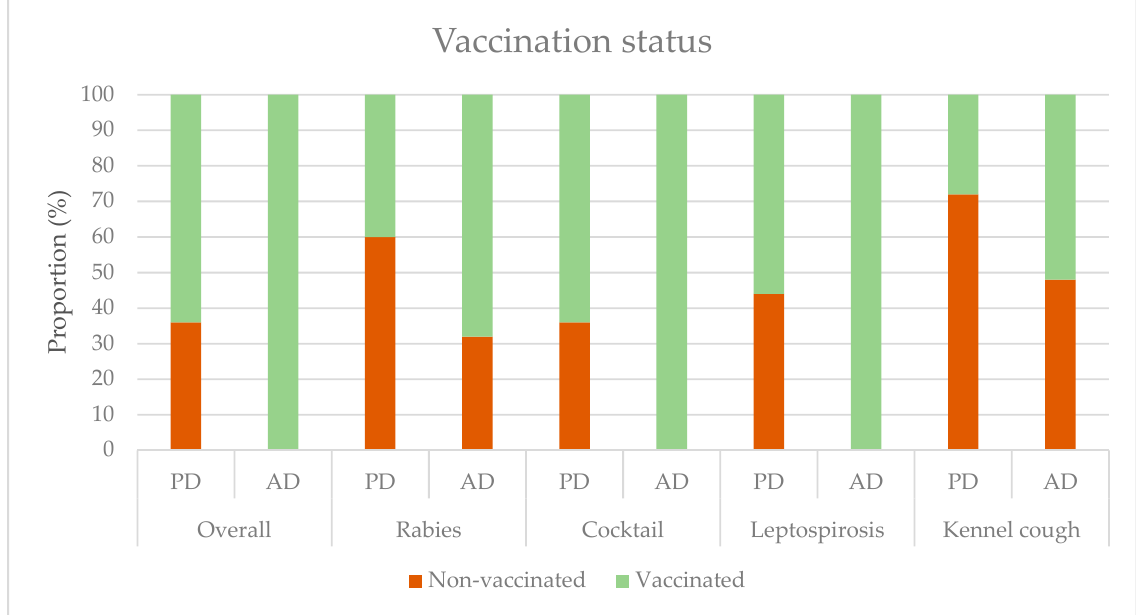
Figure 1. The vaccination status of pet dogs (PD) and assistance dogs (AD): overall (vaccinated = received one or more vaccinations on recommended schedule), rabies vaccination, cocktail vaccination (canine parvovirus, canine distemper virus, and canine adenovirus causing infectious canine hepatitis), leptospirosis vaccination, and kennel cough (canine parainfluenza virus and/or Bordetella bronchiseptica ).